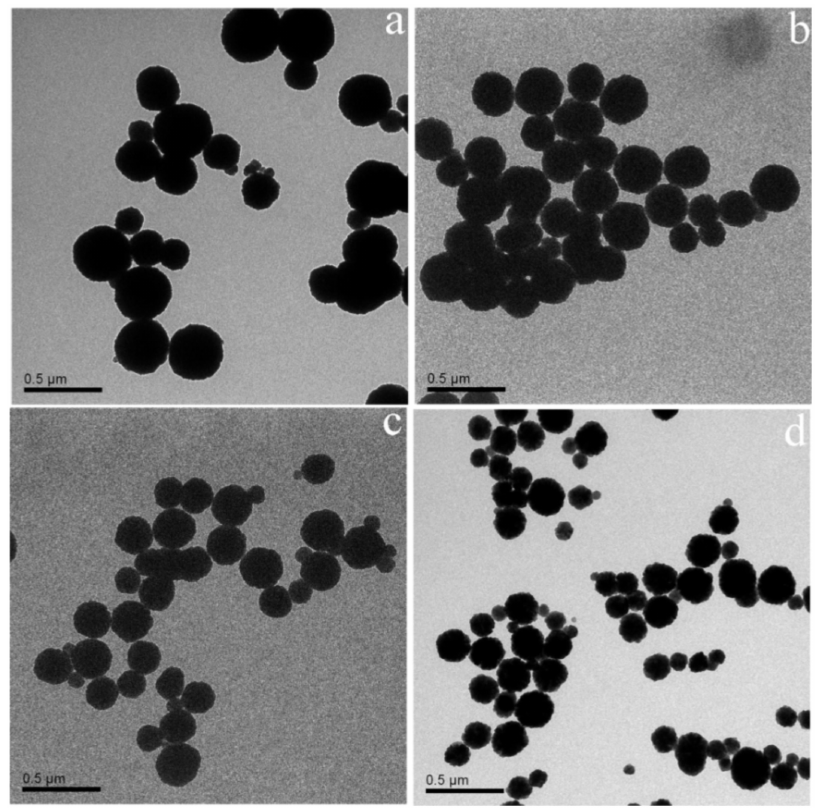
Figure 1. TEM images of PVP-coated Fe 3 O 4 MNPs (( a ): S1; ( b ): S2; ( c ): S3; ( d ):